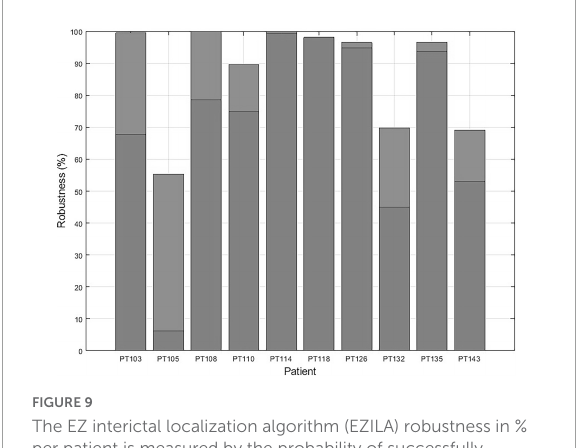
FIGURE9 The EZ interictal localization algorithm (EZILA) robustness in % per patient is measured by the probability of successfully identifying at least one channel within the clinically assessed EZ at any 10 min interictal period of the patient’s (phase II) epilepsy monitoring unit (EMU)